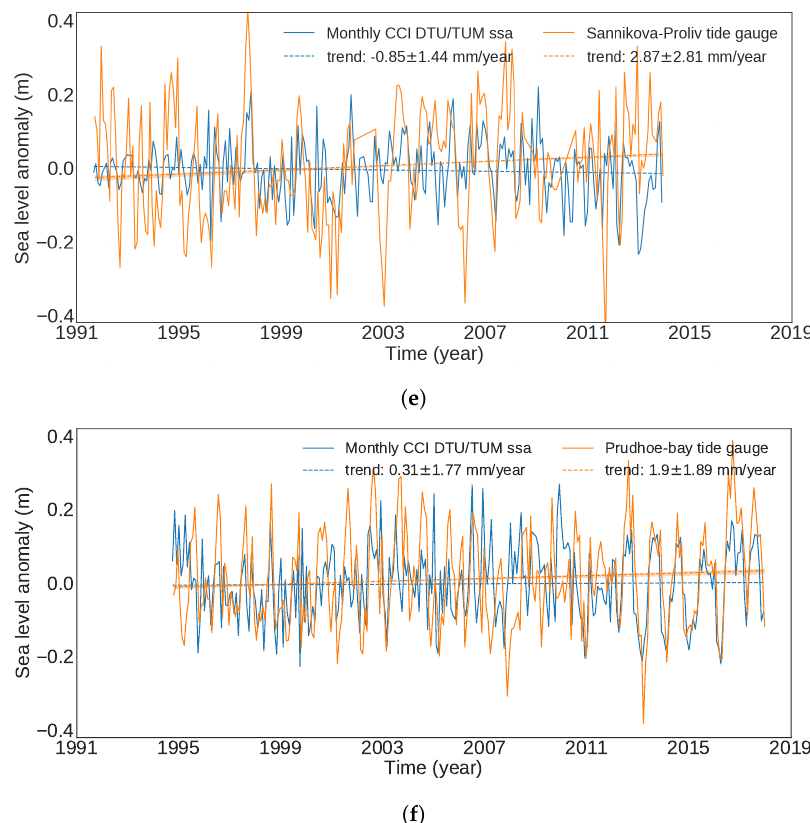
Figure A2. Tide gauge comparison of the continued altimetry time series from the six tide gauges in the period from 1991 to 2019, where blue is the altimetry data and orange is the tide gauge data. The vertical lines are the trend lines colored like the time series. The various trends are written in the captions. ( a ) Honningsvåg. ( b ) Ny Ålesund. ( c ) Vise Ostrov.( d ) Golomianyi Ostrov.( e ) Sannikova Proliv.( f ) Prudhoe